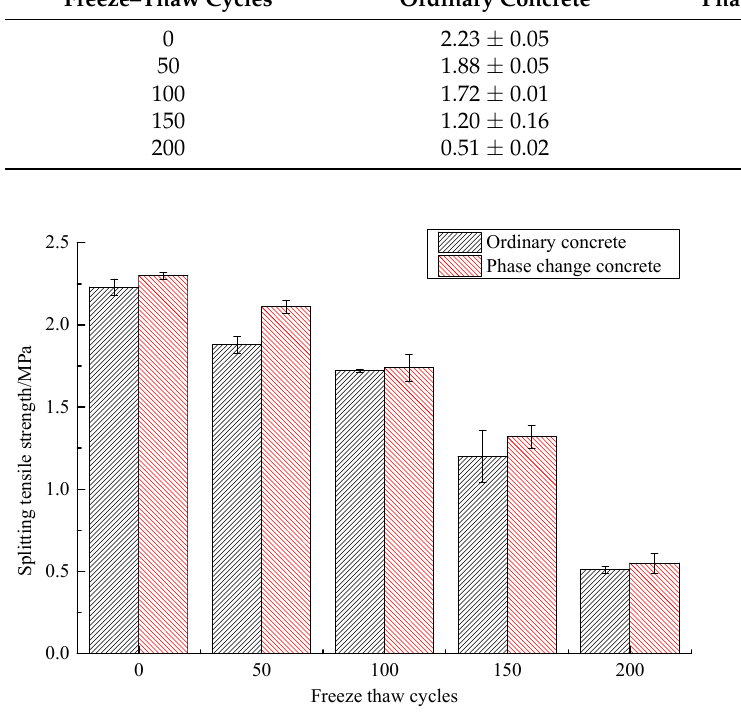
Figure 10. Variation of splitting tensile strength with freeze–thaw cycles.